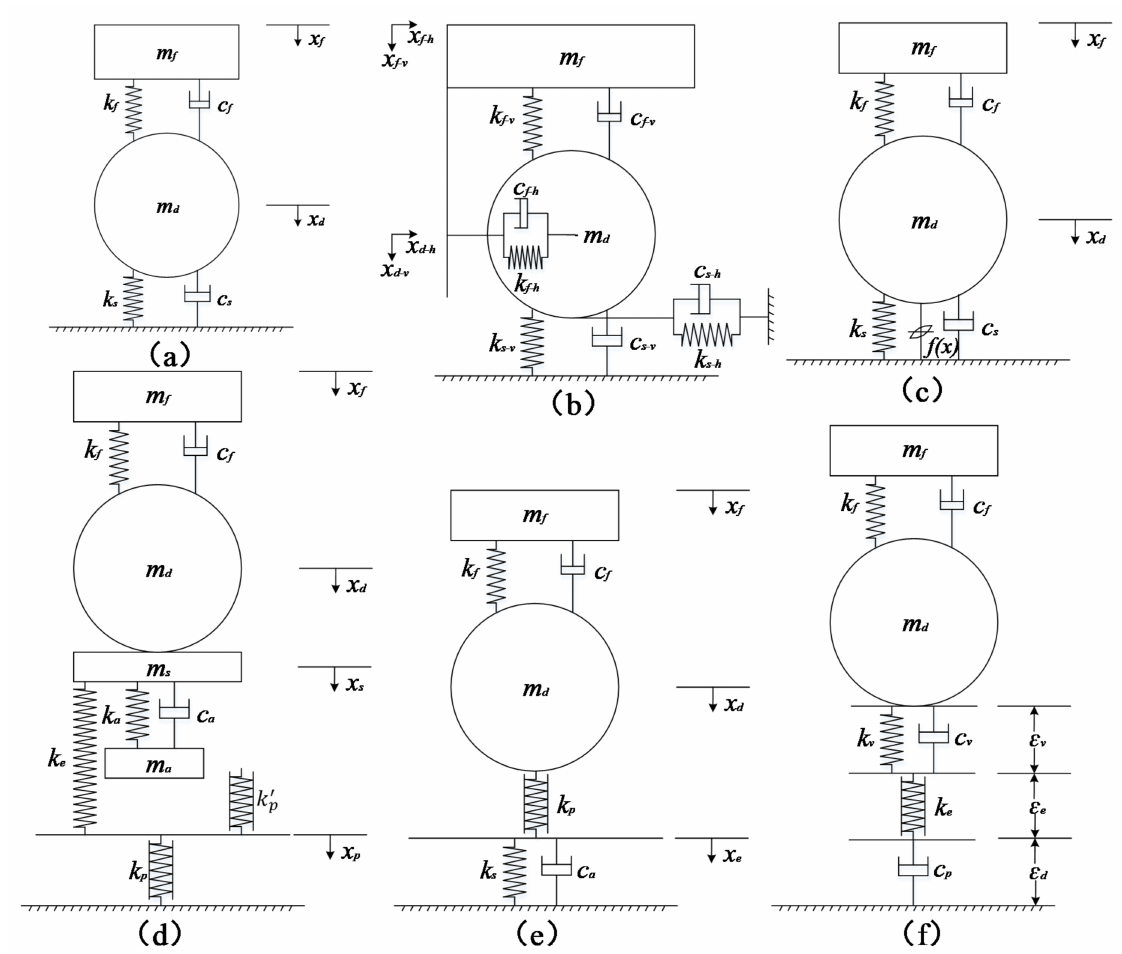
Figure 10. Several typical vibration compaction models. ( a ) piecewise linear model considering jumping vibration; ( b ) overall dynamic model; ( c ) asymmetric hysteresis model; ( d ) 4-DOF vis- coelastic plastic model; ( e ) 3-DOF viscoelastic plastic model; ( f ) viscoelastic plastic model based